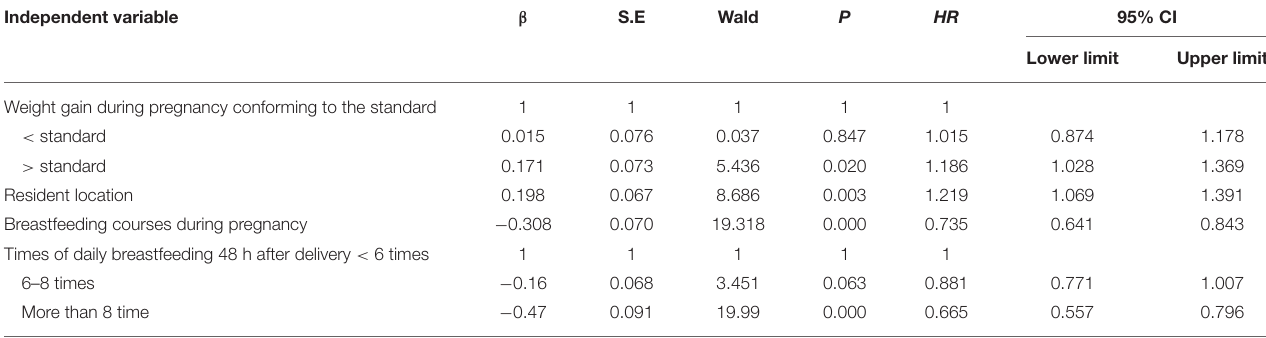
TABLE 6 | Cox proportional hazard model. Independent variable β